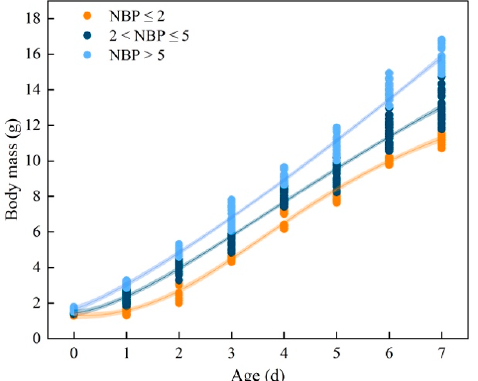
Figure 5. The relationship between body mass and age (days after birth) of Asian short-toed lark ( Alaudala cheleensis ) nestlings ( n = 45). NBP is the proportion of the daily grasshopper nymph biomass relative to the total biomass measured on all survey days. The shaded area is the confidence interval.